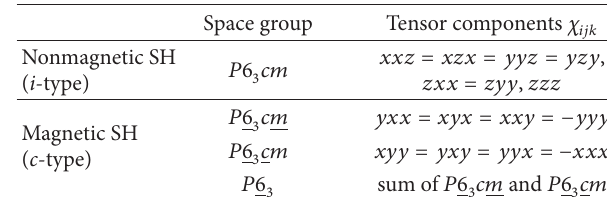
Table 1: Nonvanished susceptibility tensor components for hexago- along the z